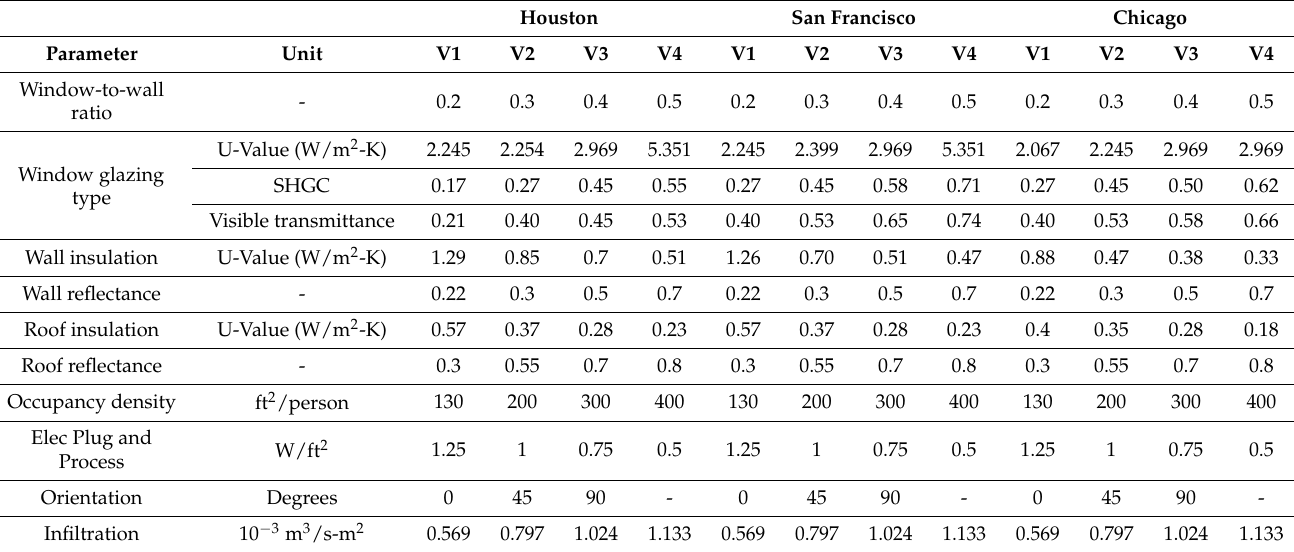
Table 2. Parameter variations of building characteristics. V1–V4 indicate the discrete values that each parameter can have in this